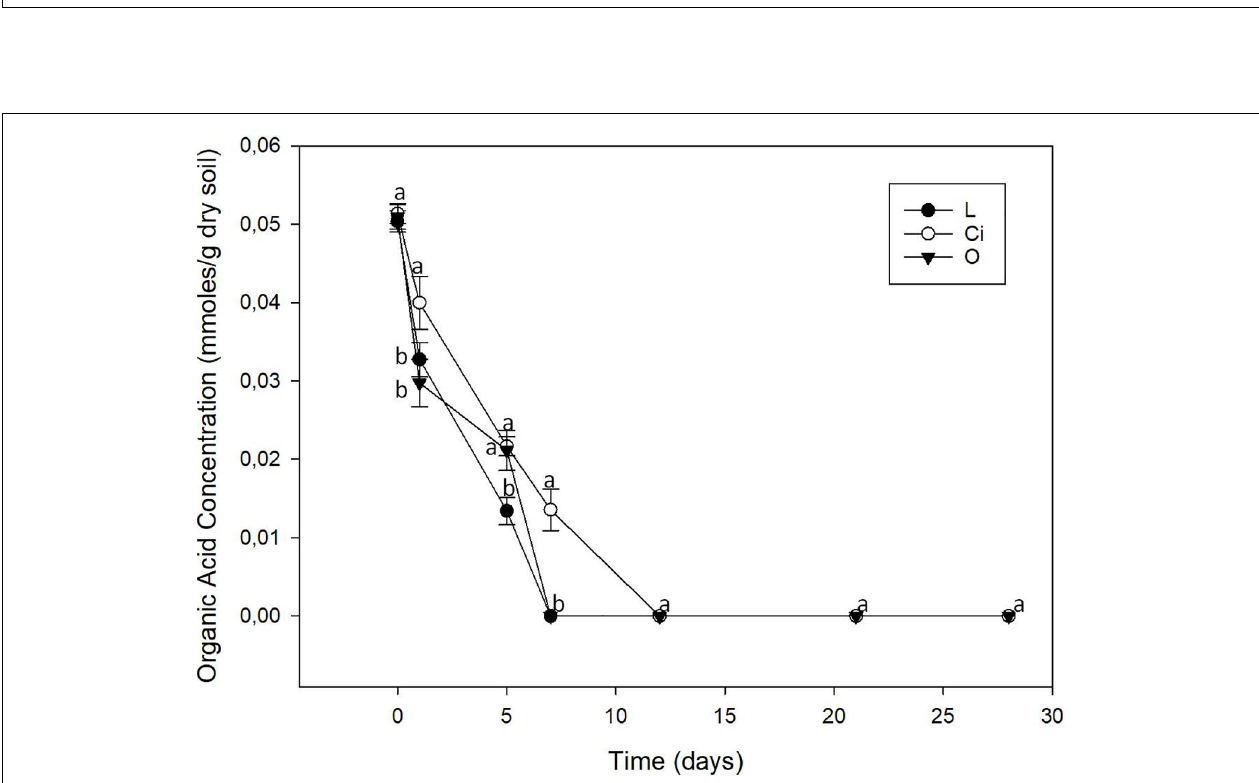
Frontiers in Plant Science |